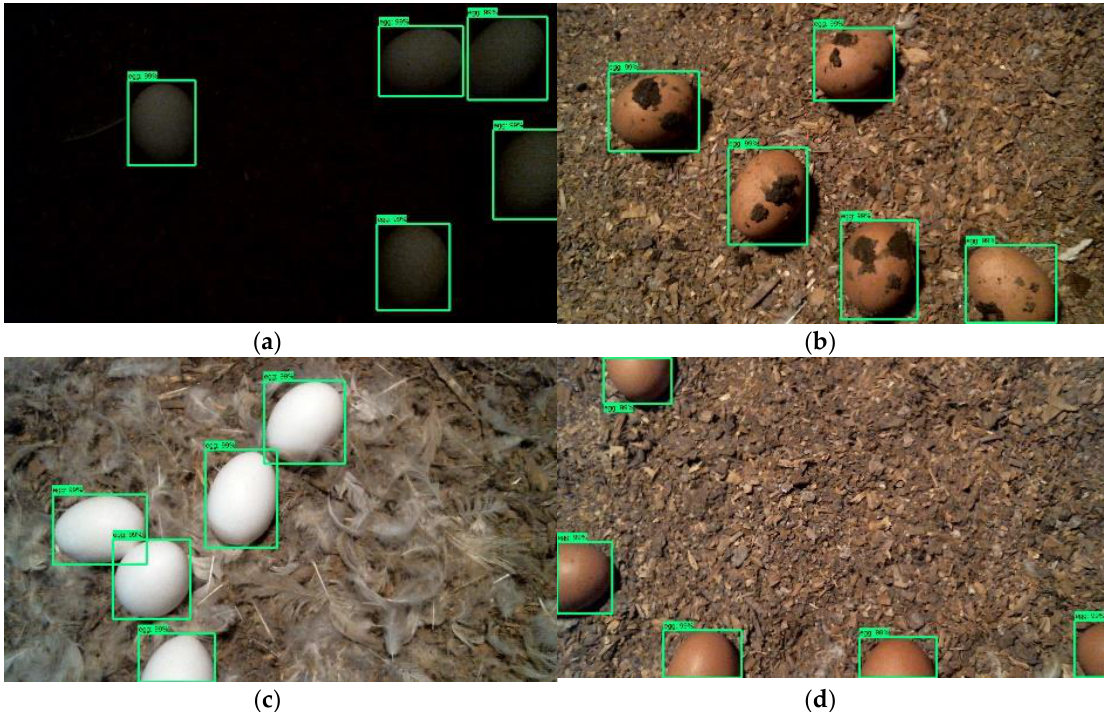
Figure 6. Sample images of floor egg detection under different settings: ( a ) five white eggs at the 1-lux light intensity; ( b ) five brown eggs with litter contamination; ( c ) five white eggs on the feather-mixed litter; ( d ) 50% of brown egg proportion in an image. Eggs in the images are detected and enclosed with green bounding boxes.